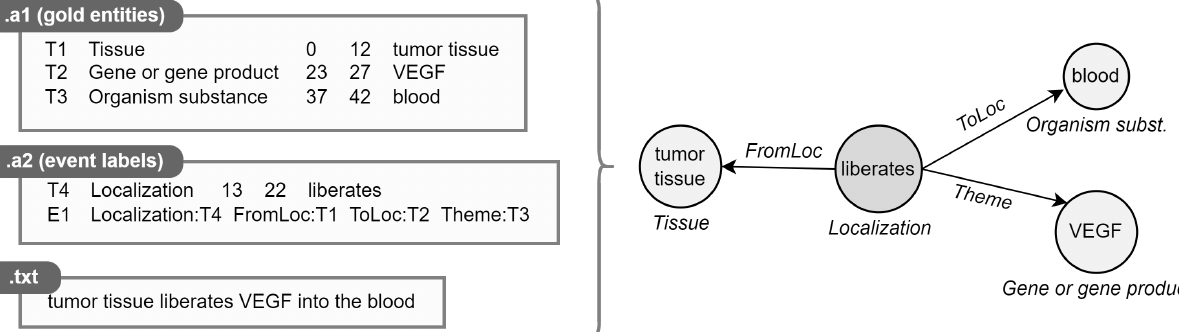
Figure 5. Example of .a* parsing. The textual document is shown for